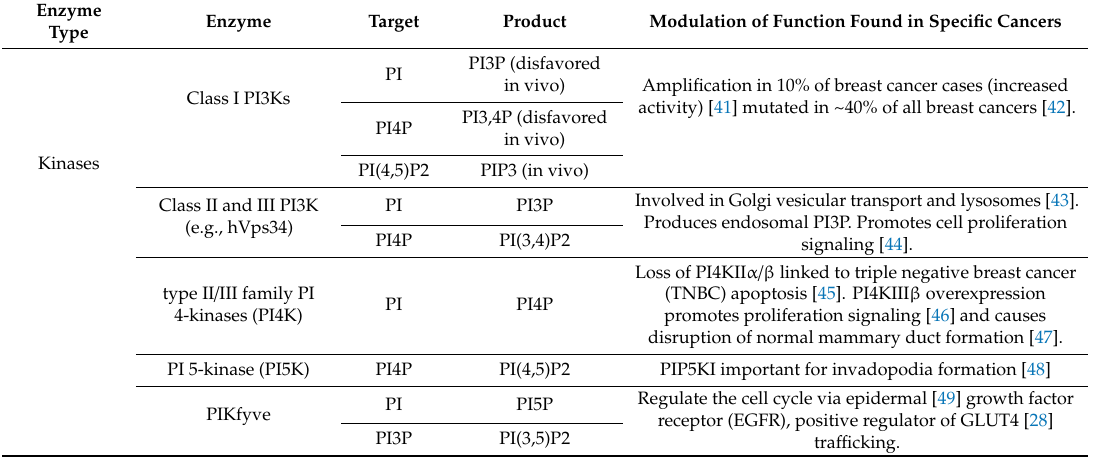
Table 1. Phosphatidylinositol enzymes with known modulations of function in